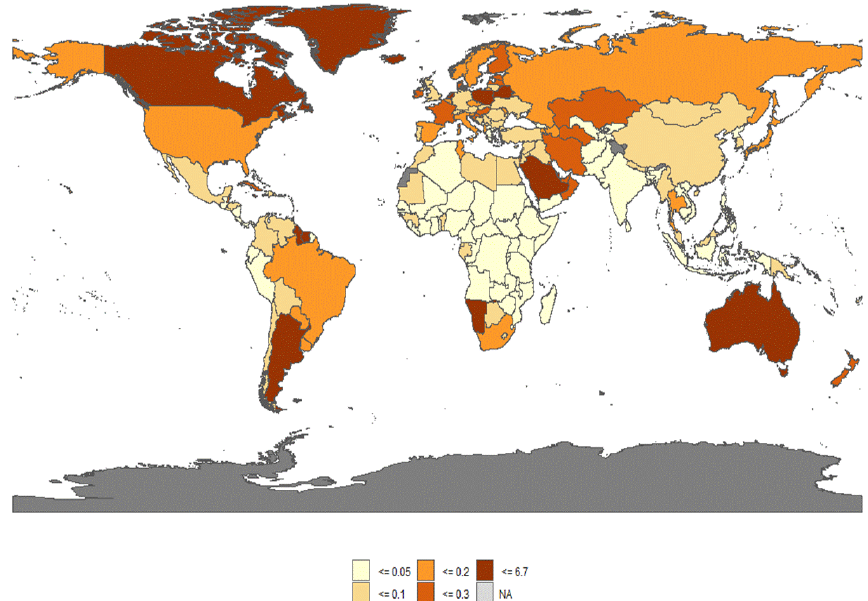
Figure 7. GHG emission from energy used in agriculture per capita in 2019 (tCO 2 eq per person). Source: emissions data from FAOSTAT, 2021. Population data from the World Bank (https://data.worldbank.org/indicator/SP.POP.TOTL, last access: July 2021), complemented with United Nations Department of Economic and Social Affairs (UN DESA) population data for Falkland Islands, Guadeloupe, French Guiana, Martinique, Niue, Réunion, Romania, State of Palestine and Democratic Republic of the